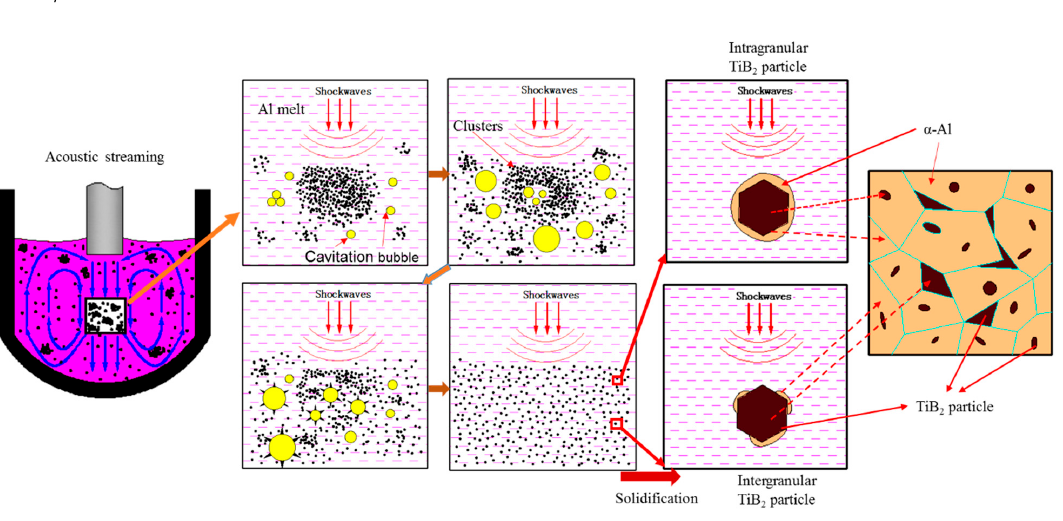
Figure 6. Schematic diagram of ultrasonic cavitation and acoustic streaming phenomenon in the TiB 2 /2A14 composites melt. TiB / 2A14 composites 2